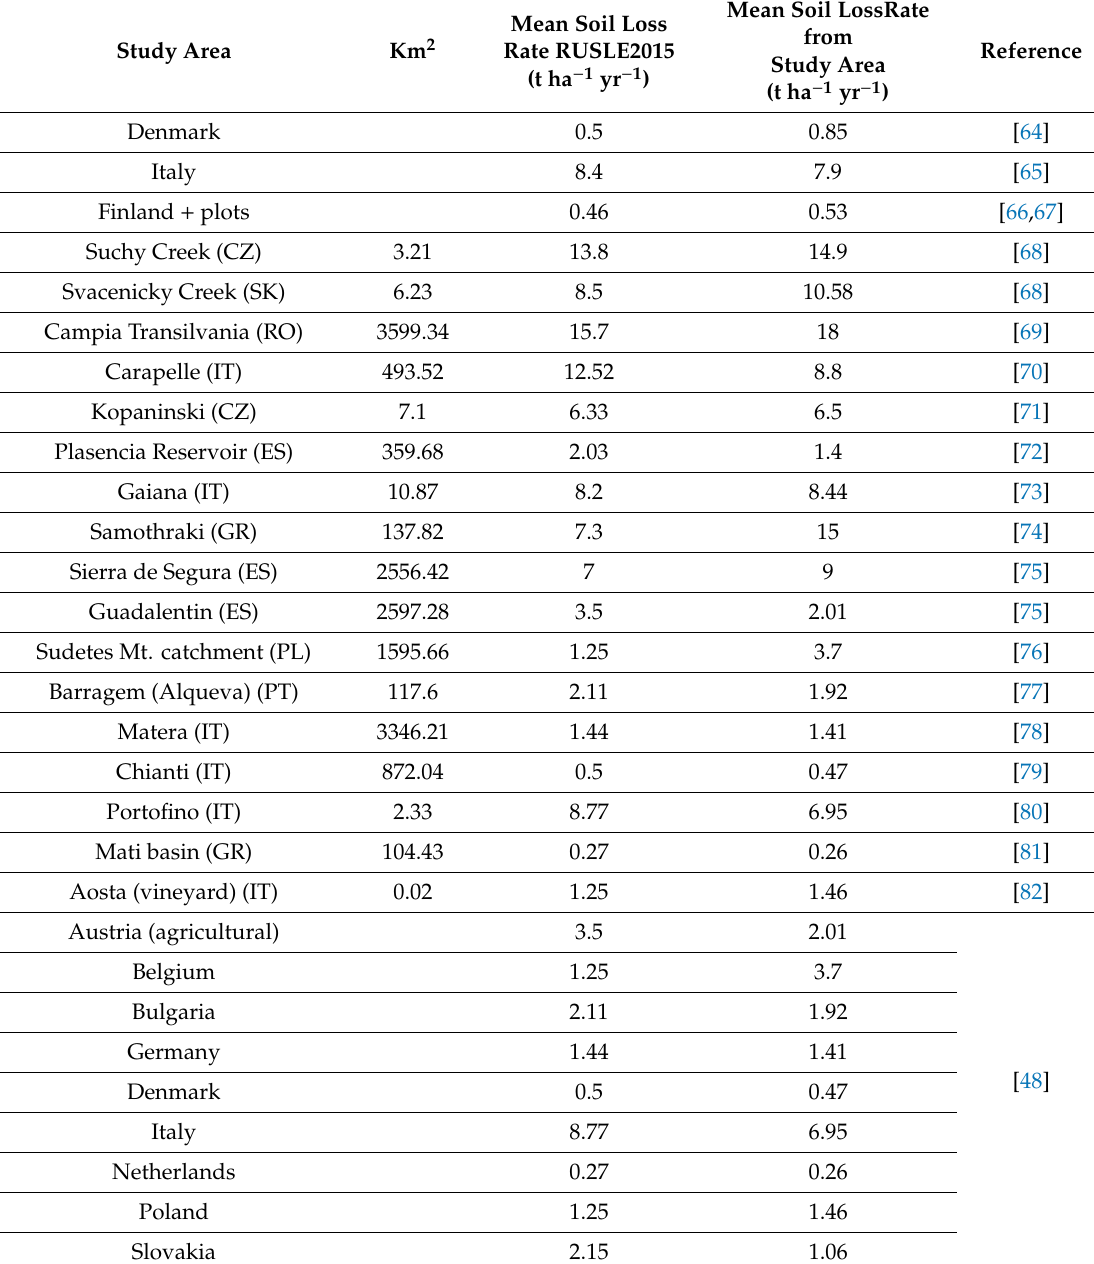
Table A1. Comparison of erosion rates between RUSLE2015 model outputs and regional